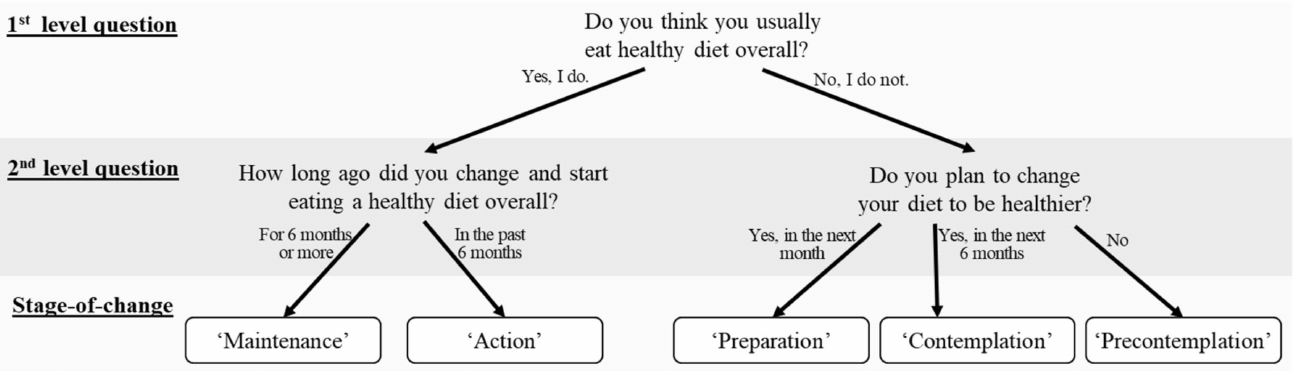
Figure 1. The two-level questions of healthy eating